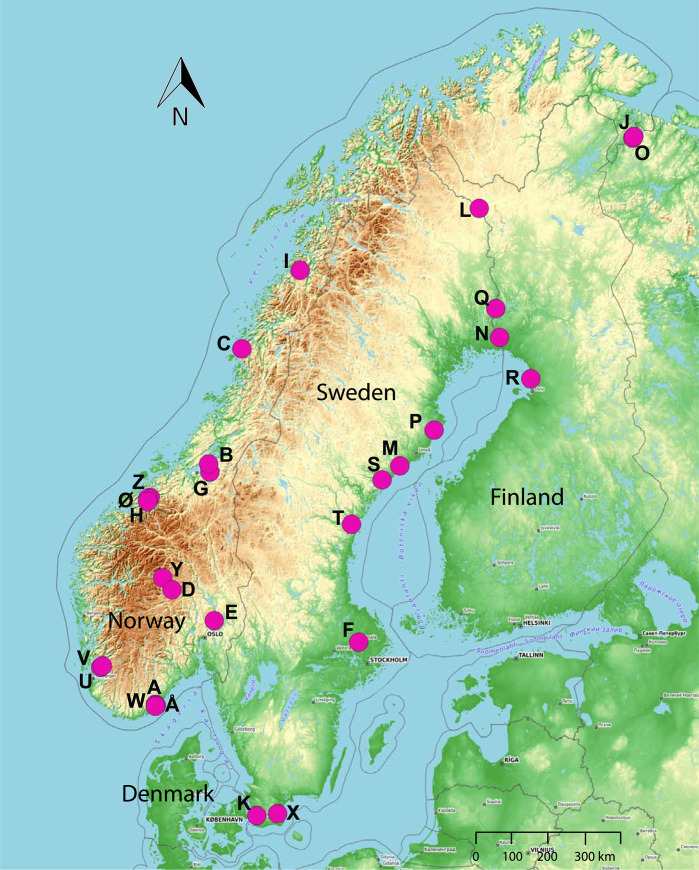
Geographical map of the sampling of 669 apple fruit moth larvae in 28 sampling locations (pink dots marked from A to Å, see Table 1) on the Scandinavian Peninsula.